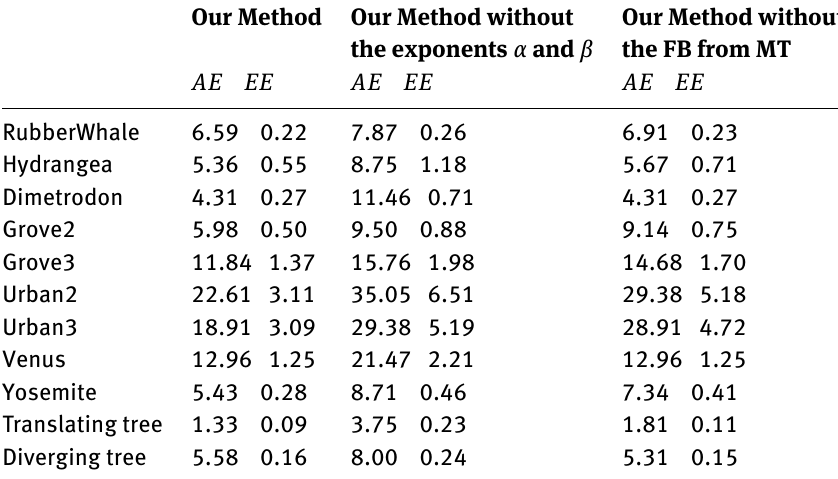
Table 2: Error statistics for motion perception estimation for a variety of synthetic and real-world image sequences (Dataset 2).